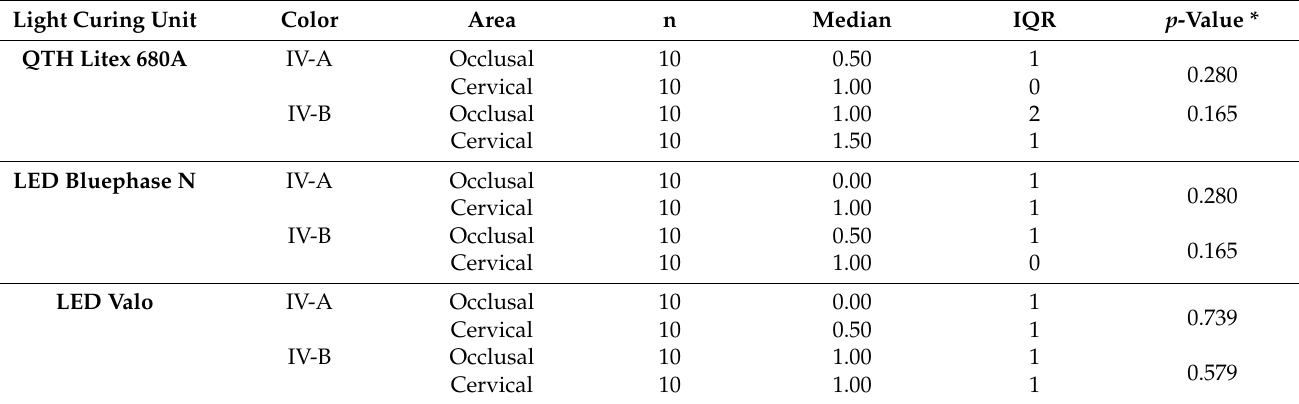
Table 4. Microleakage of dental restorations with Tetric N-Ceram resin composite according to occlusal and cervical area.